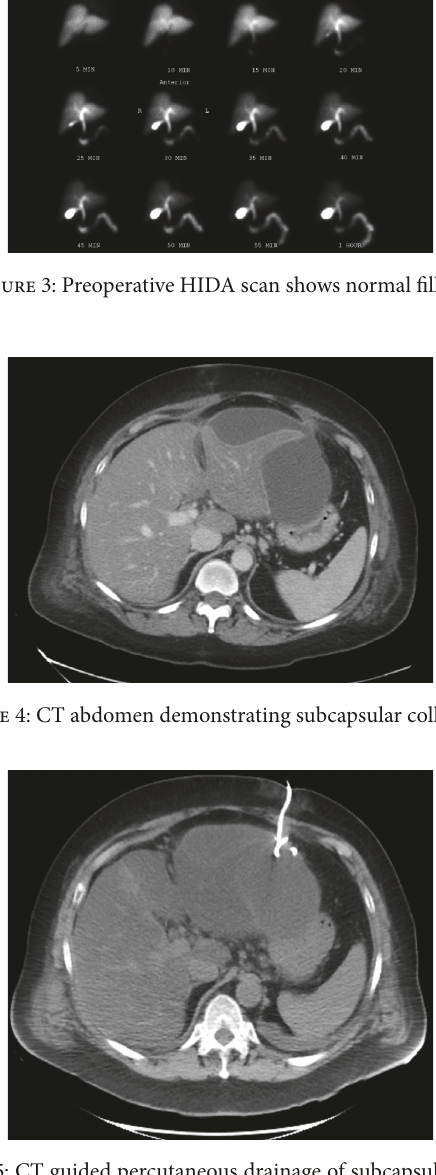
Figure 5: CT guided percutaneous drainage of subcapsular collec-